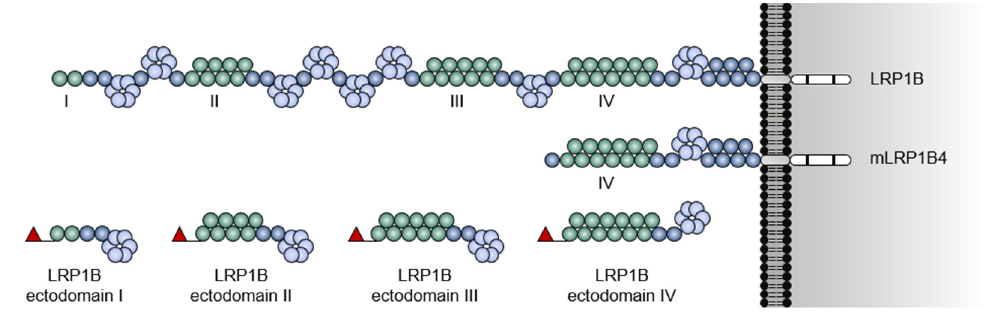
Figure 4. Structure comparison between full-length LRP1B, LRP1B minireceptor (mLRP1B4), and N-terminal-tagged LRP1B ectodomains I, II, III, and IV. The extracellular ligand-binding domains (I to IV) are identified. The red flag represents the N-terminal tag.